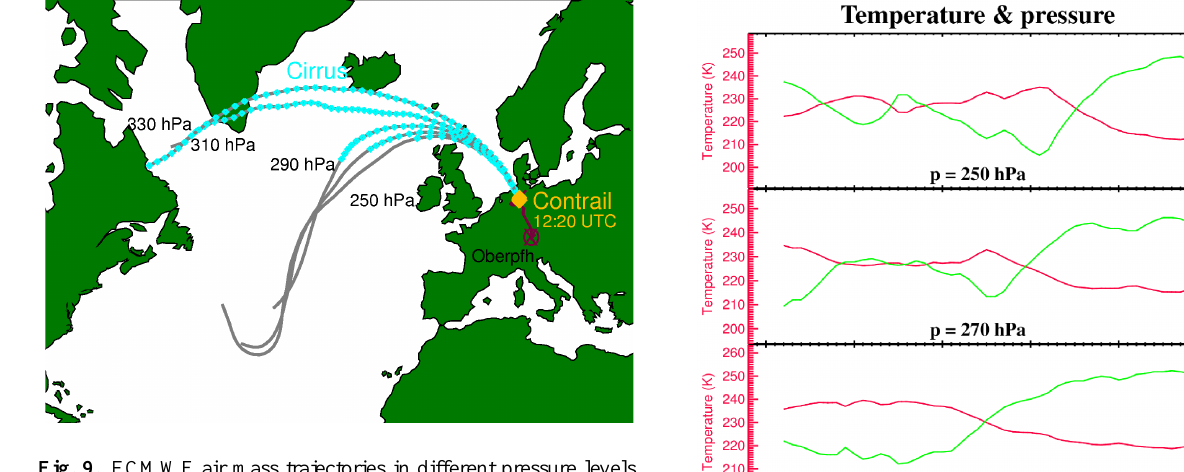
Fig. 10. Temperature and pressure along the trajectories shown in Figure 9, ending at the point of contrail detection at 310 hPa. In the 310 hPa panels, big dots denotes the observations (see Figures 5 and 6).